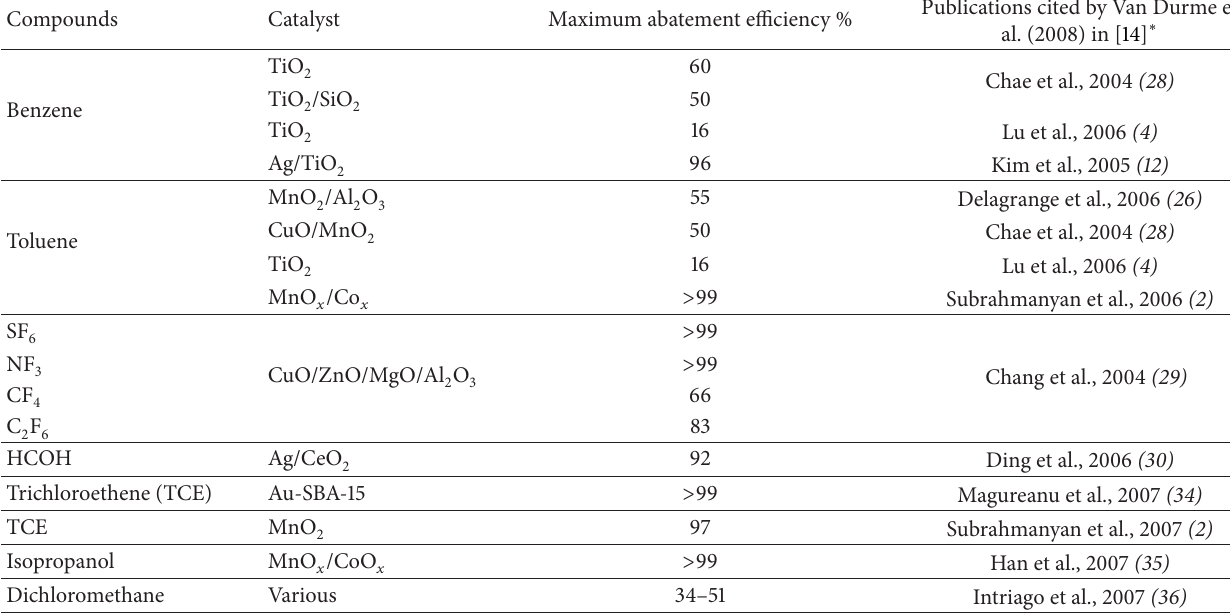
Table 1: VOC abatement efficiencies with DBD-NTP-CAT tests.